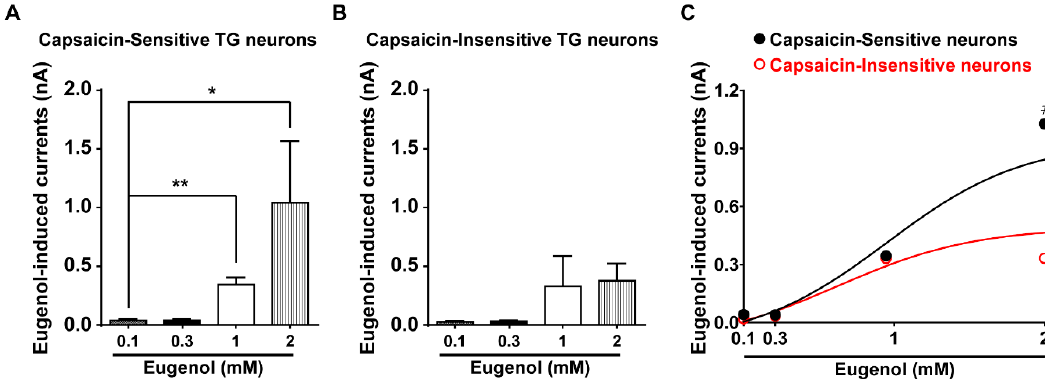
Figure 3. Eugenol induced inward currents in TG neurons. ( A ) Eugenol induced inward currents in capsaicin-sensitive small-sized TG neurons (15–25 μ m diameter) in a dose-dependent manner (from 0.1 to 2 mM). ( B ) Eugenol induced inward currents in capsaicin-insensitive TG neurons (from 0.1 to 2 mM). ( C ) Summary of the effect of eugenol on capsaicin-sensitive and -insensitive small-sized TG neurons ( n = 39 and n = 22, respectively). * p < 0.05 versus control, ** p < 0.01 versus control and # p < 0.05, capsaicin-sensitive versus capsaicin-insensitive.